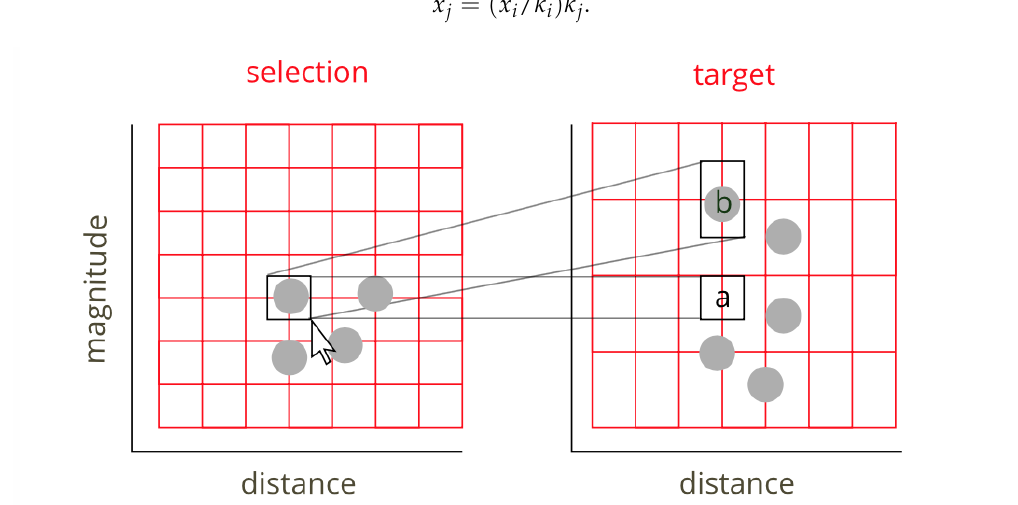
Figure 3. Selection over different datasets in the scatterplot is facilitated by our distribution-aware selection tool. A range selected in one scatterplot is not merely transposed to a , which would probably end in an empty selection, but linearly transformed into b , according to the grid automatically defined based on the distribution of each